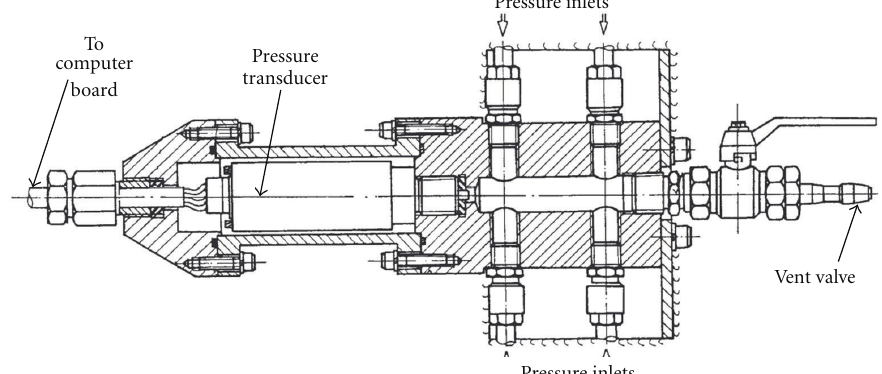
Figure 3: A waterproof manifold with details of the absolute pressure transducer location.